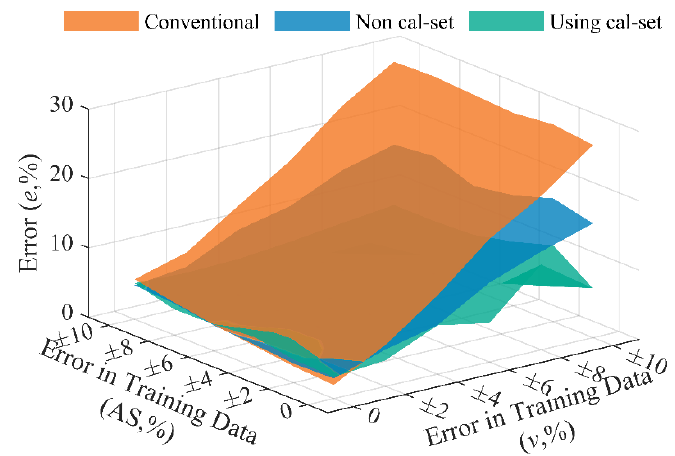
Figure 14. Axle weight identification error (%) of BwimNet using a calibration set. Cal-set, the abbreviation of calibration set.